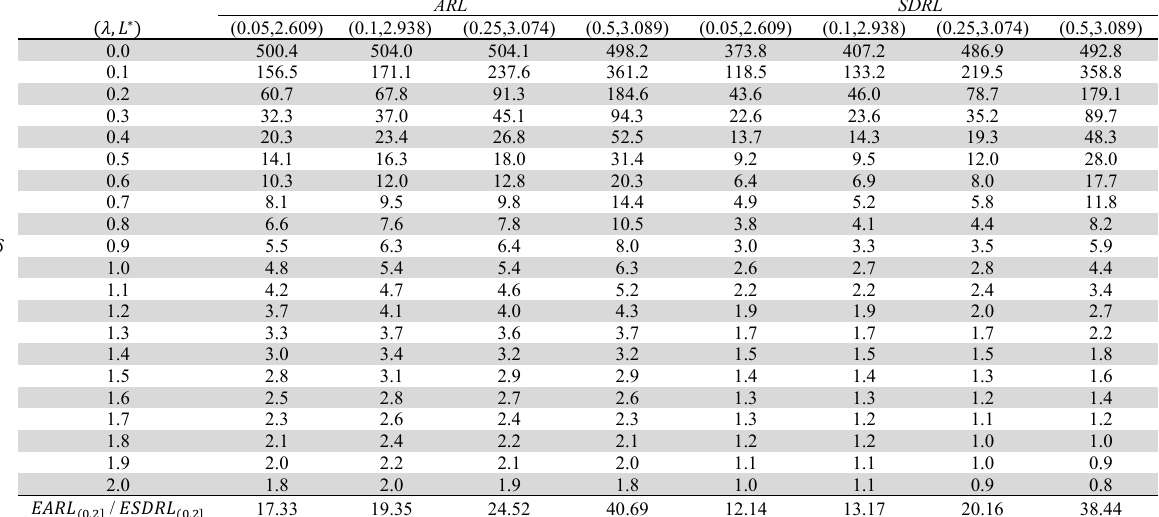
The ARL and SDRL profiles of the HWMA 𝑋(cid:3364) ∗ scheme (for the no remedy strategy) for different values of 𝜆 along with